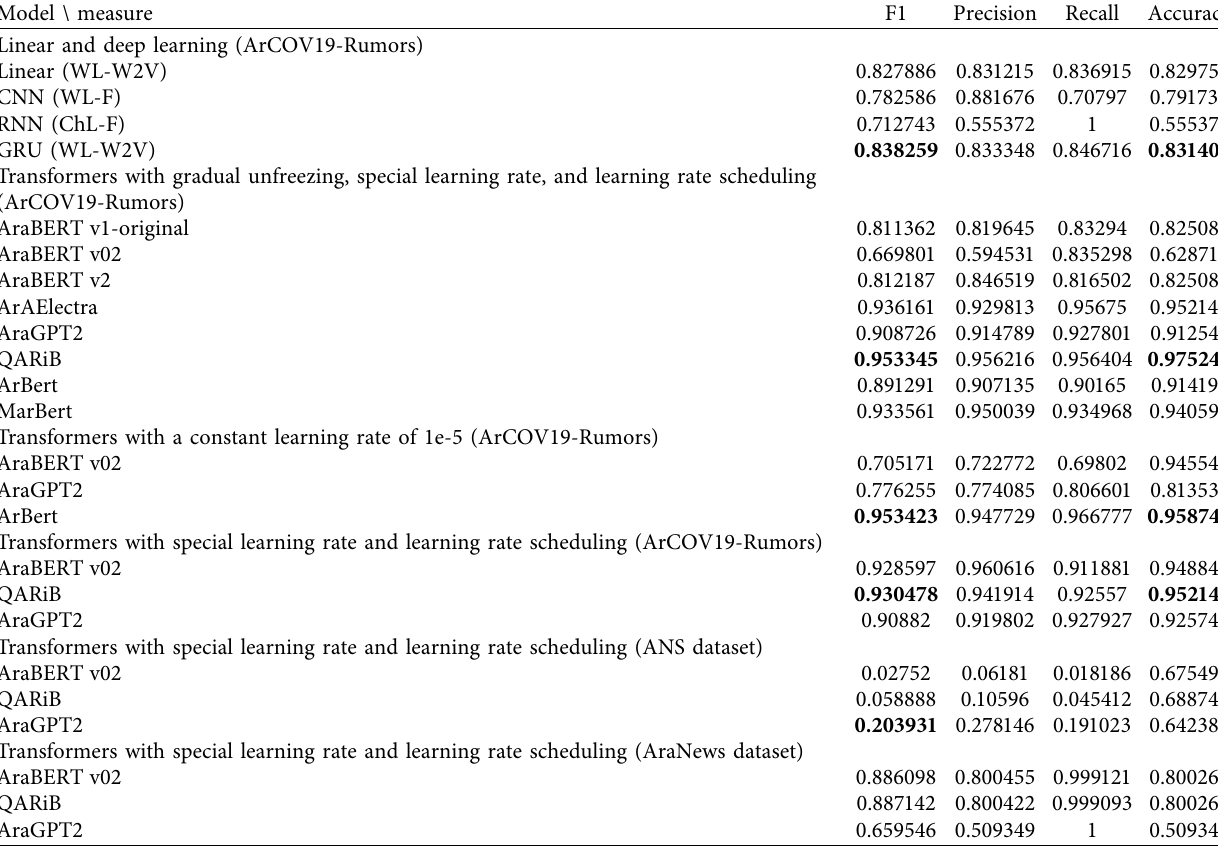
Table 2: FND model performance on ArCOV19-Rumors, ANS, and AraNews datasets. Model \